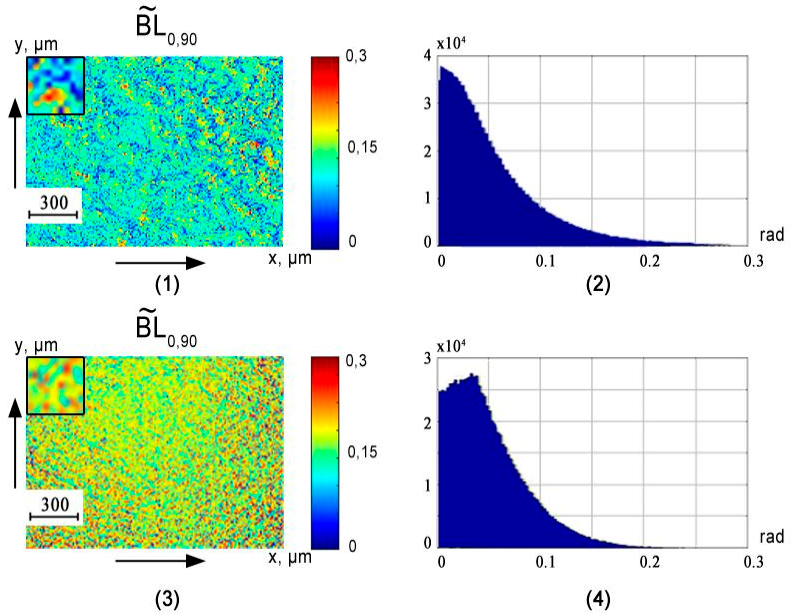
Figure 3. An example of maps and histograms of the DT red spatial distribution fluctuations of the linear birefringence ~ LB of polycrystalline blood films taken from healthy donor (( 1 ) and ( 2 )) and cancer patient (( 3 ) and ( 4 )).